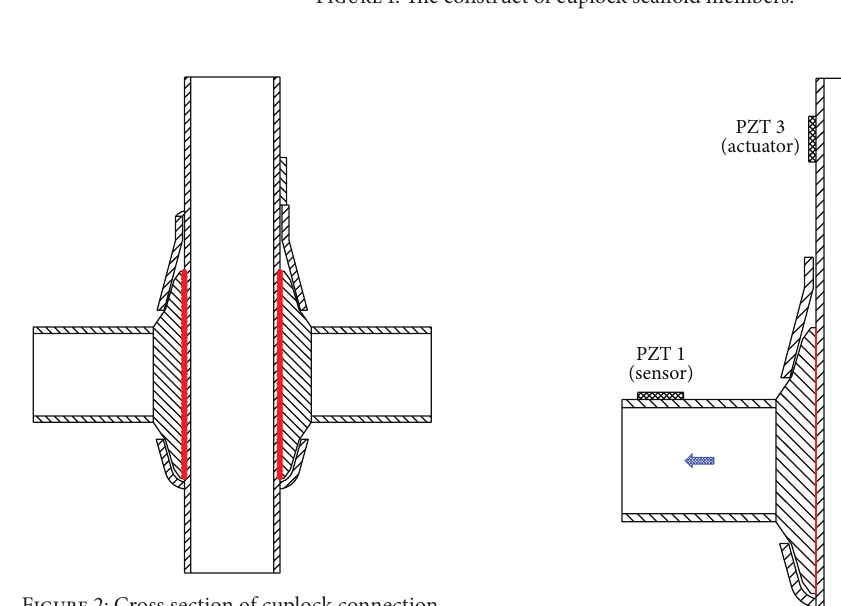
Figure 1: The construct of cuplock scaffold members.